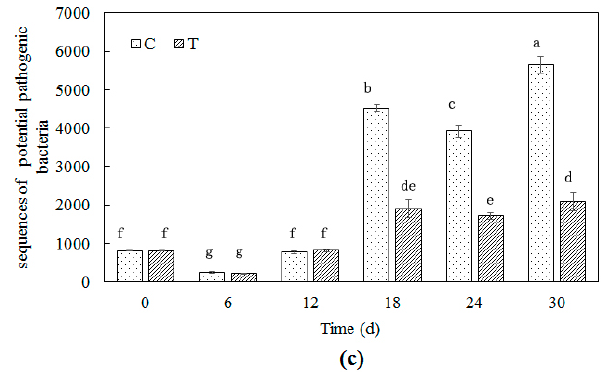
Figure 4. Change of total bacterial number ( a ), total coliform levels ( b ) and potential pathogenic bacteria levels ( c ) in the controls (C) and the water hyacinth treatments (T) over time. Different letters were marked in histograms to indicate significant differences ( p < 0.05).